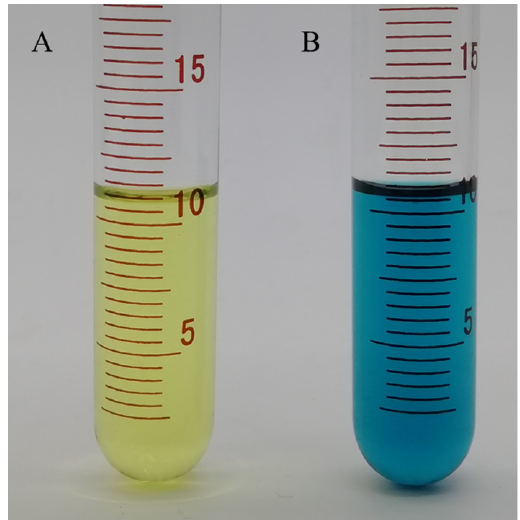
Figure 10. The color change after adding potassium ferricyanide to the CDs/Fe 3+ solution with or without adding ascorbic acid ( A tube contains a mixed solution without ascorbic acid and B tube contains a hybrid solution with ascorbic acid).